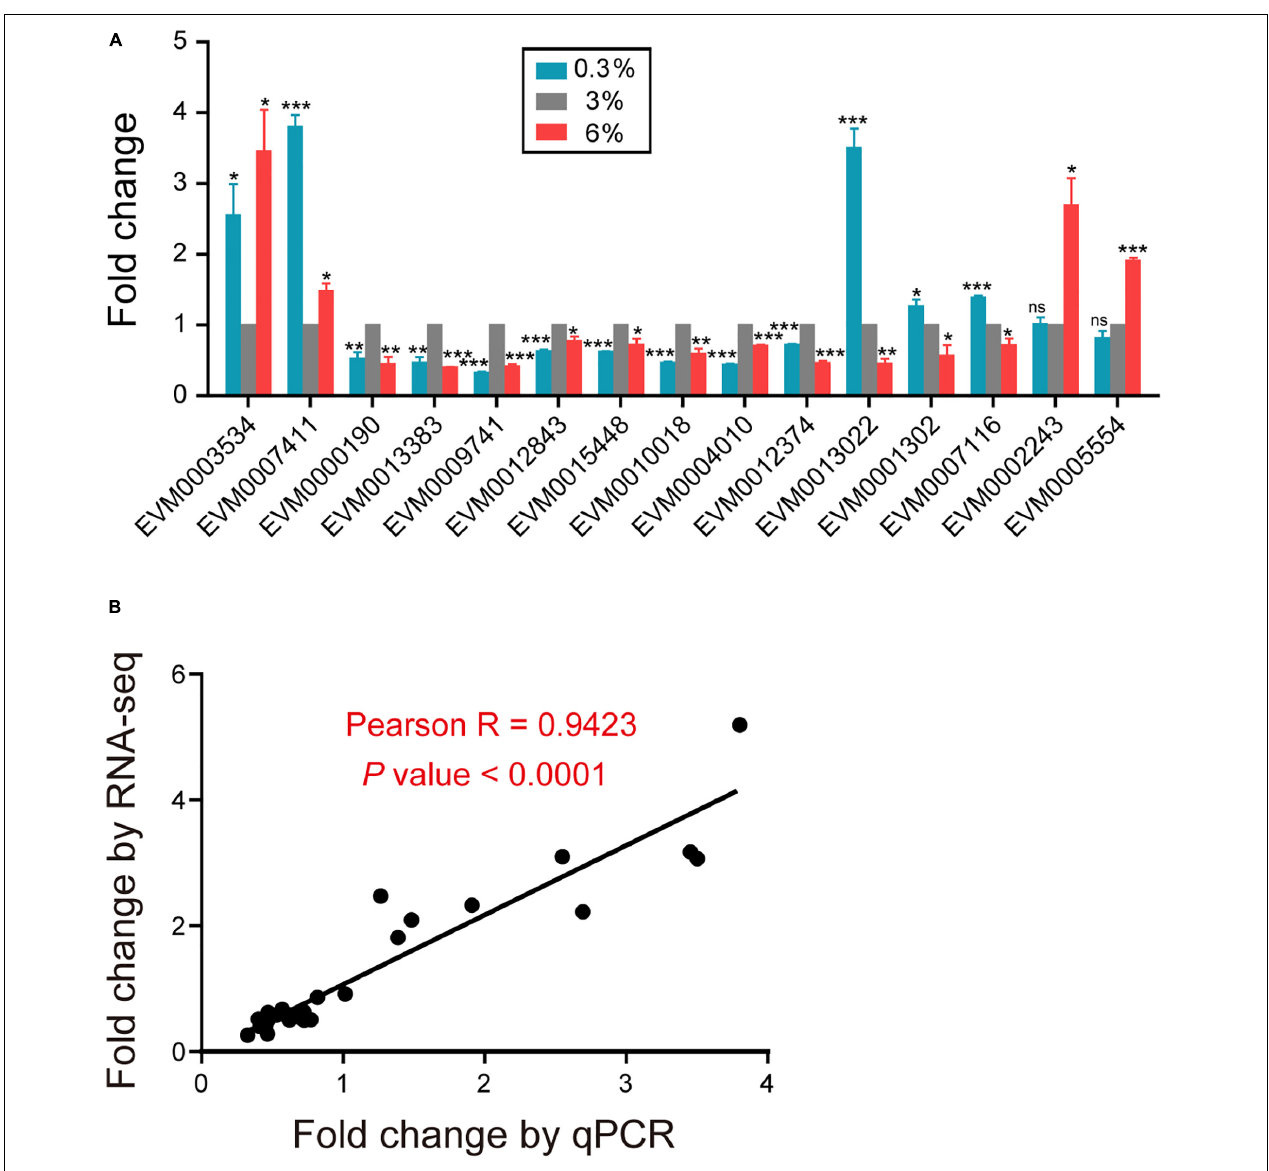
FIGURE 6 | Validation of the RNA-seq results using qPCR. (A) qPCR analysis of interest genes identified from the RNA-seq results. Gene expression was presented as a fold change, indicating the ratio of the treatment group (0.3%, 6%, as indicated) to the control group (3%), which was calculated by the delta delta Ct method. The mean fold changes and standard error of the mean of three biological replicates are graphed. The comparisons between the treatment and control groups were analyzed statistically employing the two-tailed Student’s t -test using IBM SPSS Statistics 19 software. P < 0.05 was considered statistically significant. * P < 0.05, ** P < 0.01, *** P < 0.001, ns–not significant. (B) Correlation analysis of the results of RNA-seq and qPCR for interest genes. Each dot represents a gene, with detailed information shown in Supplementary File 3 . Correlation analysis was performed and graphed using GraphPad Prism 5 software, Pearson R = 0.9423, with a P <